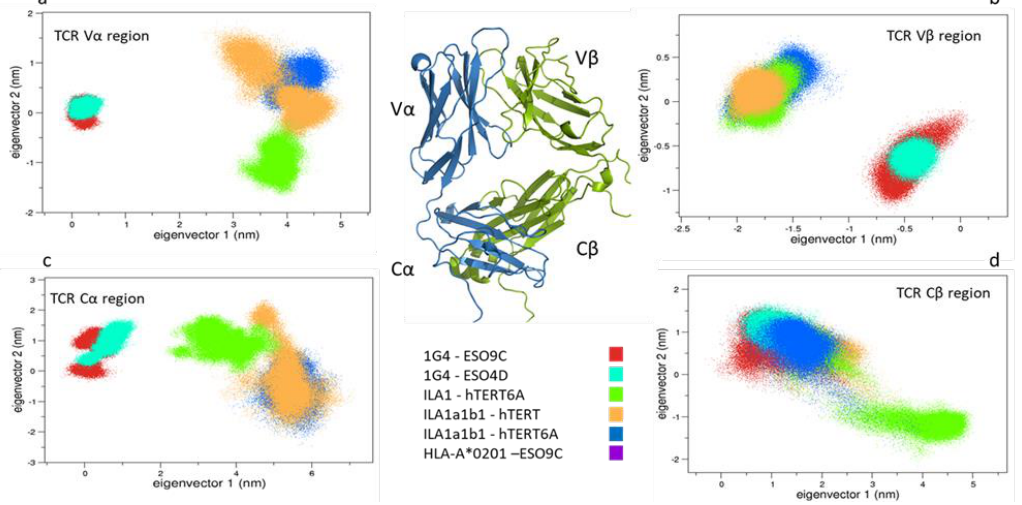
Figure 5. Comparison between the bound states. The projections of the TCRs Variable (Panels a-b) and TCRs Constant regions (Panels c – d ) are reported.